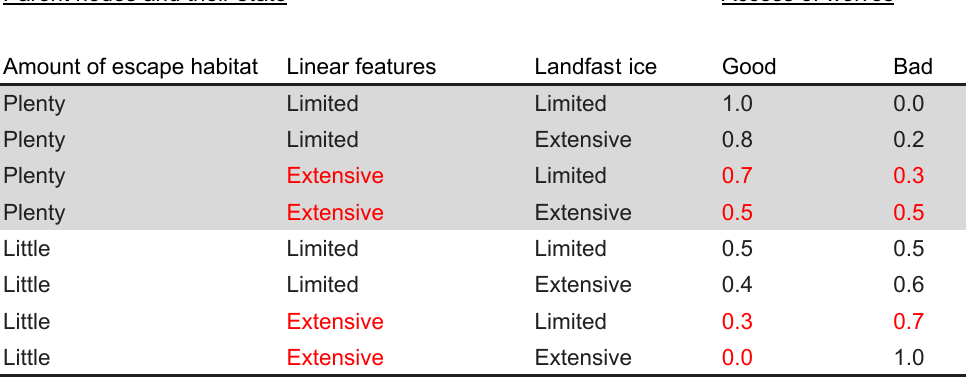
Table A9. Conditional probability table for node access of wolves (to